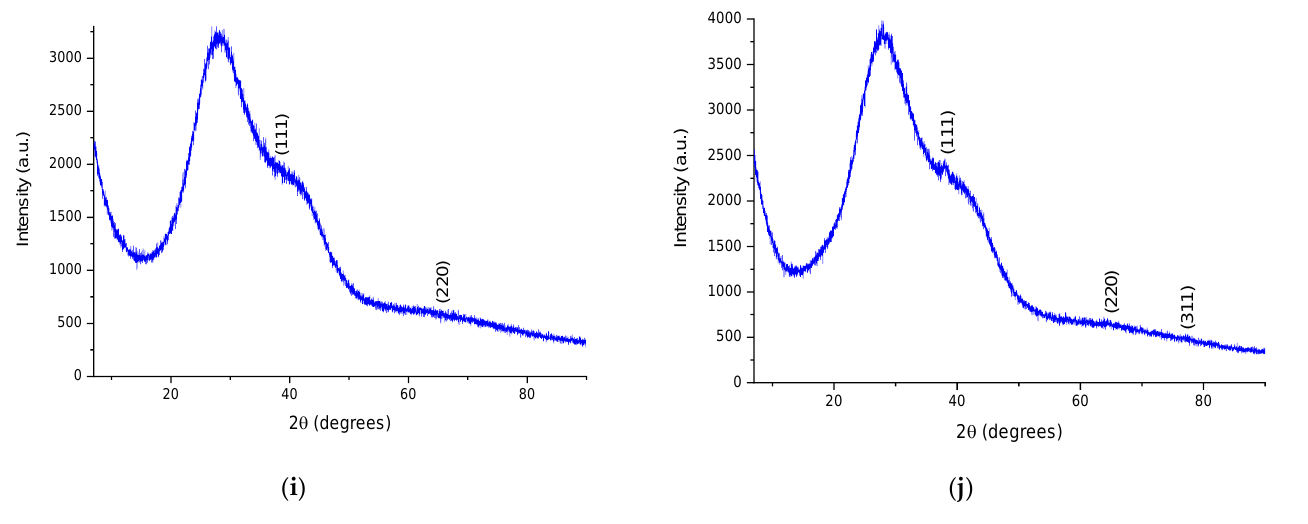
Figure 5. Diffractograms of the phytosynthesized nanoparticles: ( a ) sample EE5; ( b ) sample EE2.5; ( c ) sample EE2; ( d ) sample EE1.25; ( e ) sample EE1; ( f ) sample EM5; ( g ) sample EM2.5; ( h ) sample EM2; ( i ) sample EM1.25; ( j ) sample EM1; Miller indices are presented on each image. Table 5. The positions of the diffraction maxima and the crystallite sizes of the analyzed samples, Considering all the results obtained, three samples were selected for each set calculated according to Equation (3).